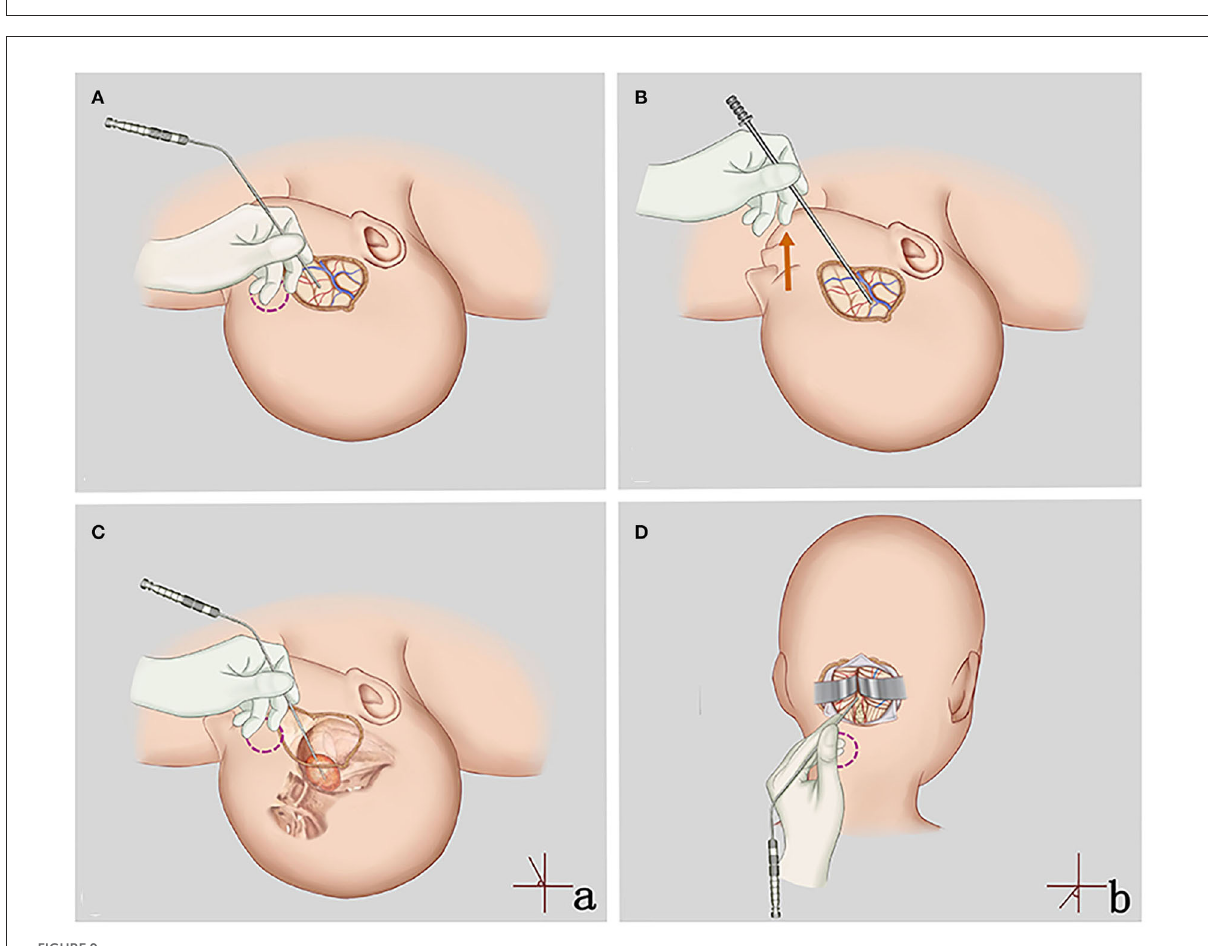
FIGURE9 (A,C,D) Application of the APS tube for superficial and deep craniotomy. Neurosurgeons can flexibly adjust the angle (a,b) and the actual working length of the APS tube and find an appropriate fulcrum (red circles), which is conducive to safe, stable, and accurate surgery. (B) Application of the traditional tube for superficial craniotomy. The surgeon’s hand is suspended and unstable (red